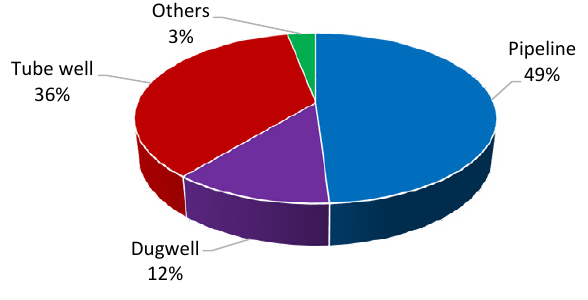
Fig 2: Different types of water supply